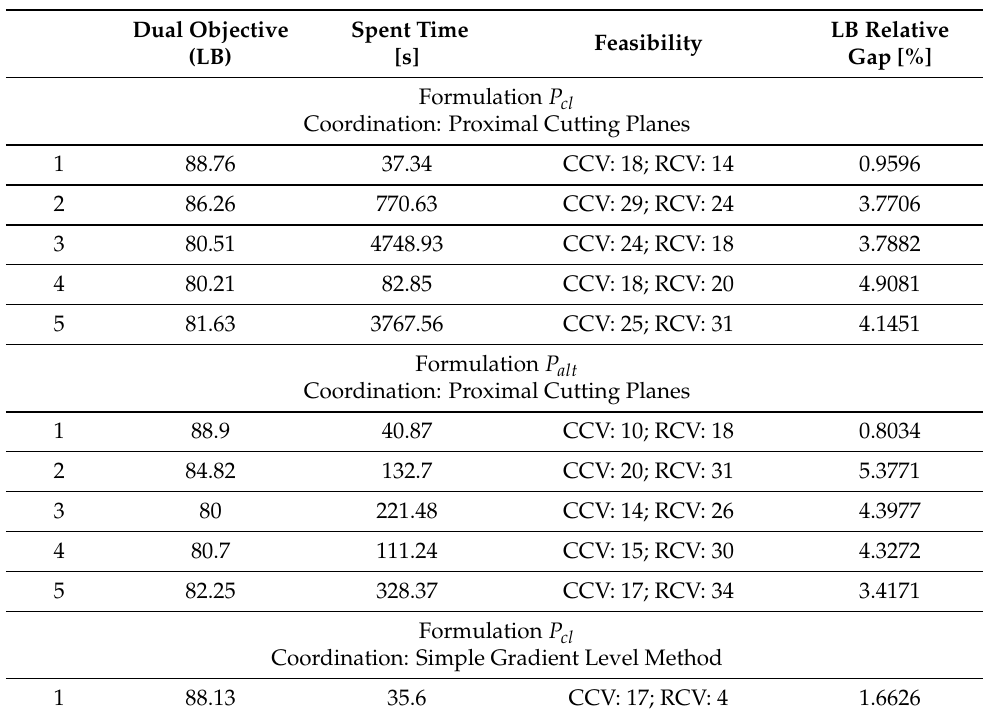
Table 5. Numerical results for medium problems—subnetworks